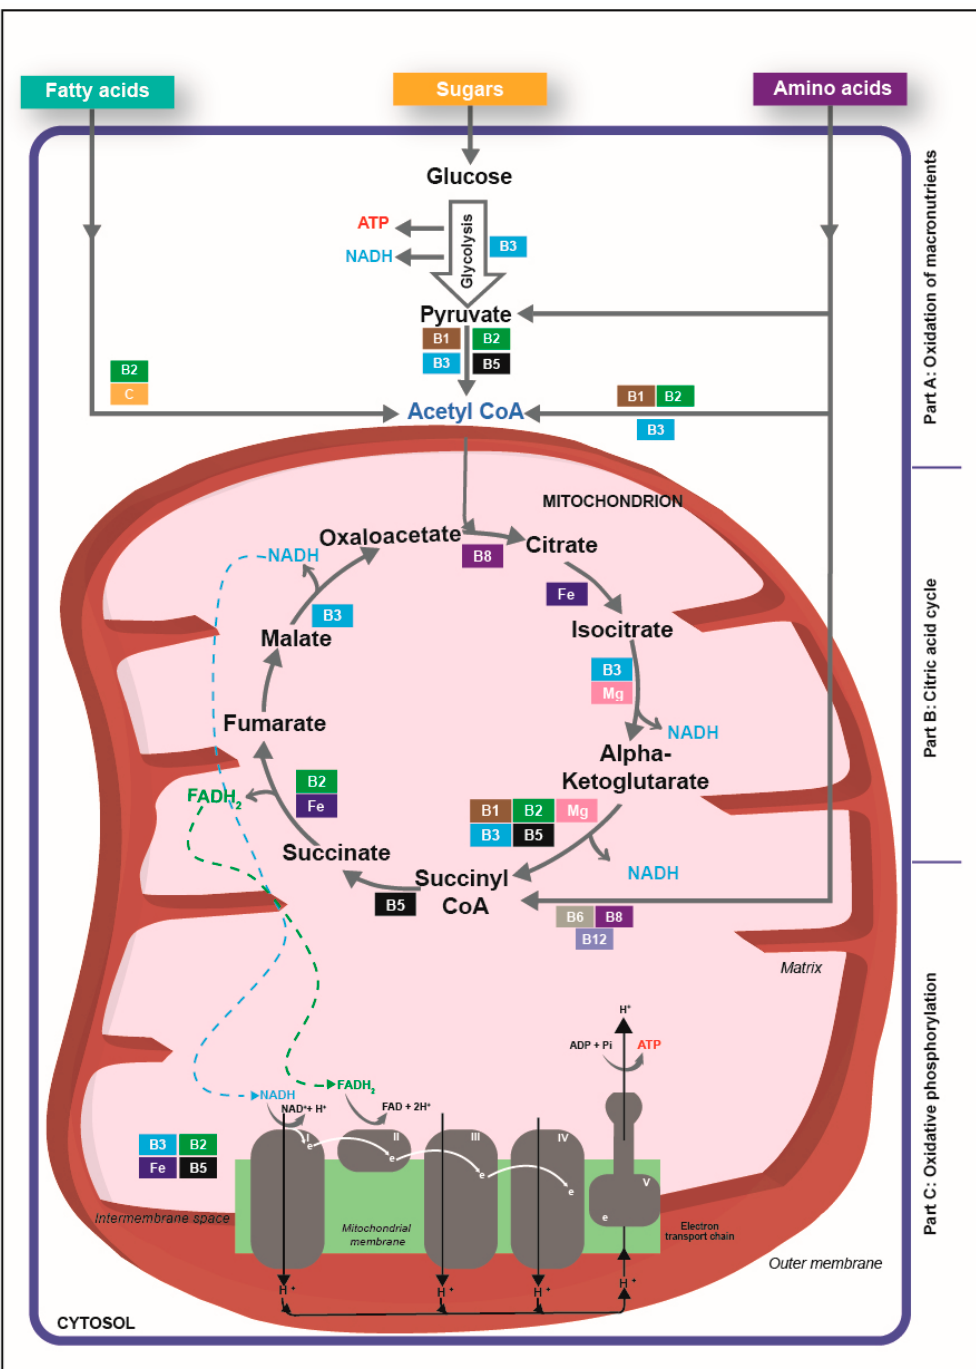
Figure 1. Overview of the involvement of vitamins and minerals in the major pathways of cellular energy production. This figure displays a simplified scheme of energy metabolism. Briefly, macronutrients are oxidized (part A) into acetyl-CoA through several pathways including glycolysis, which produces pyruvate from glucose, and vitamins B1, B2, B3, B5 and C play important roles Then acetyl-CoA enters the citric acid cycle (part B), which generates energy as NADH and FADH 2 through a series of eight oxidations that involve vitamins B1, B2, B3, B5, B6, B8 and B12 as well as iron and magnesium. Finally, the electrons of NADH and FADH 2 are transferred to the electron transport chain (part C), where they provide energy used to generate ATP molecules; this step needs the input of vitamins B2, B3, B5 and of